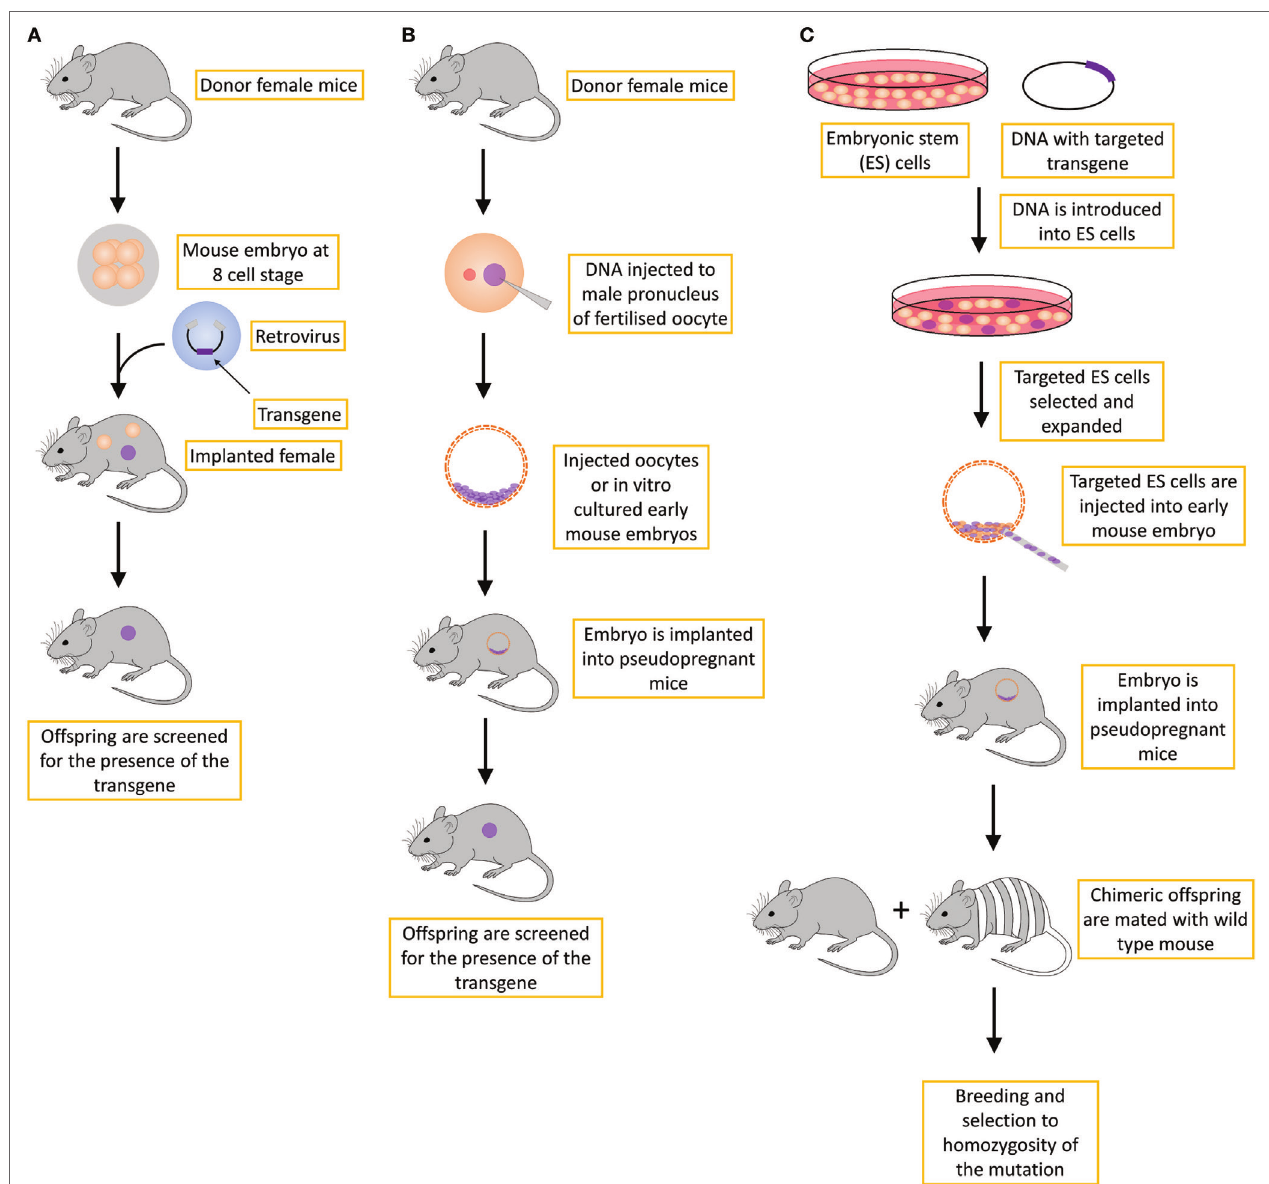
FiGURe 1 | Different strategies for creating transgenic mice include the (A) retroviral approach, which is not routinely used; (B) standard transgene approach, in which the DNA is inserted into the genome in an unspecific manner; and (C) gene-targeted transgene approach, which is an approach that is routinely used to create conventional knockout transgenic mice, usually with a constitutive loss-of-function